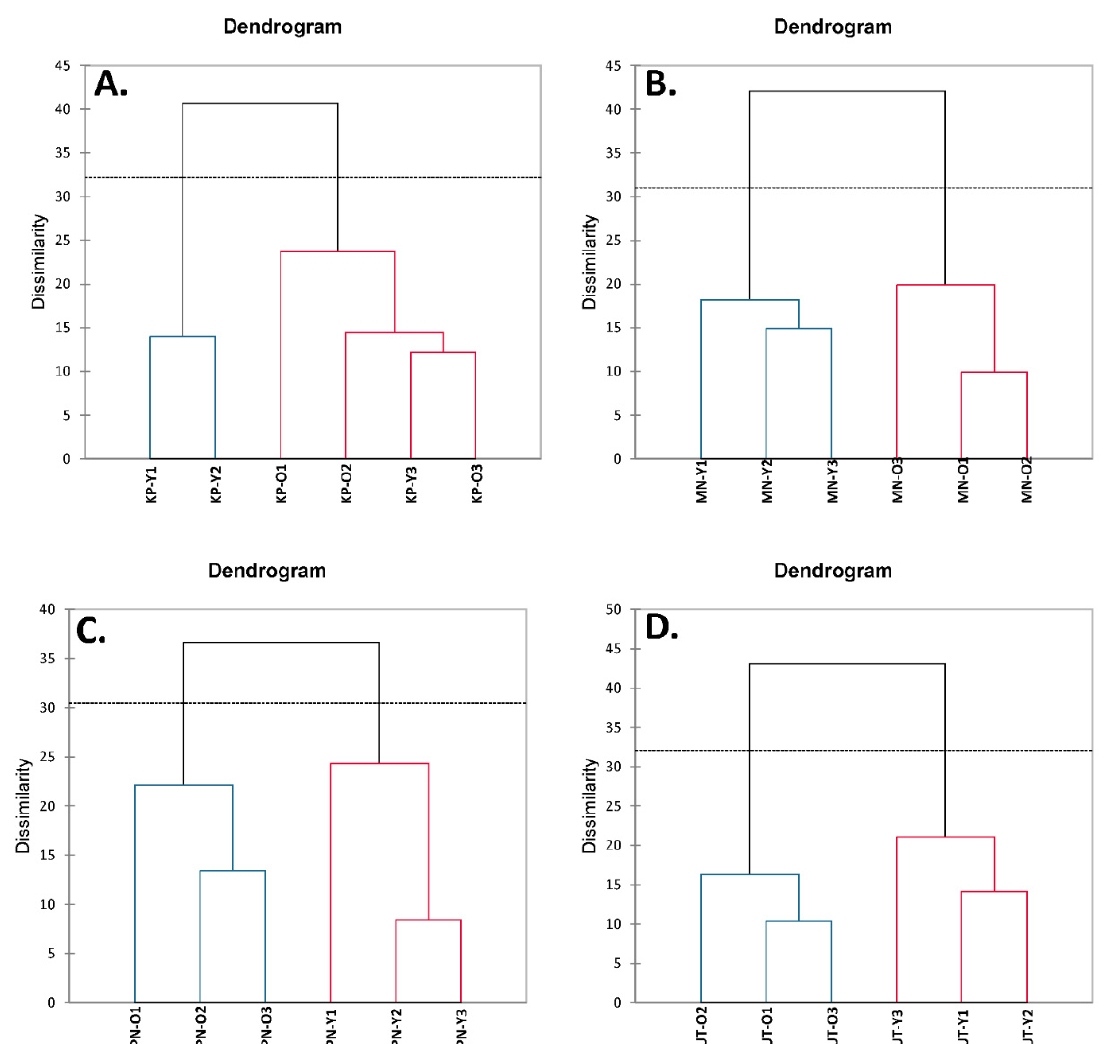
Figure 3. The dendrogram of agglomerative hierarchical cluster analysis (AHC) derived from mean of nutritive values, total phenolic contents, total flavonoid contents, and antioxidant activities in young shoots (Y) and old leaves (O) of Adenia viridiflora Craib. from different origins including ( A ) Kamphaeng Phet (KP); ( B ) Muang Nakhon Ratchasima (MN); ( C ) Pakchong Nakhon Ratchasima (PN); and ( D ) Uthai Thani (UT) collected in different harvesting periods including March–